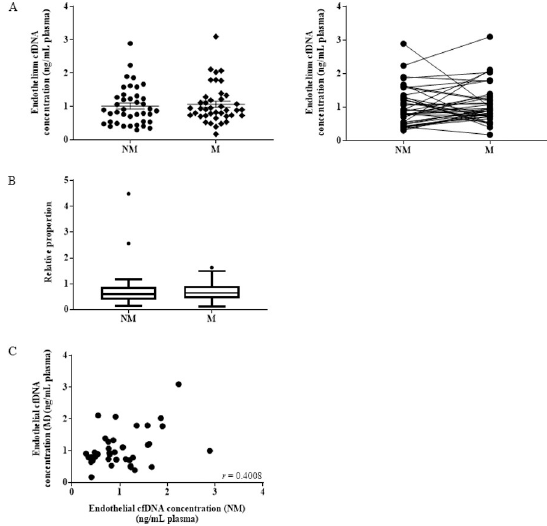
Fig 3. Endothelial cell-derived cfDNA does not increase during menstruation. (A) Measurement of endothelial cfDNA quantification by qPCR in 40 healthy women at NM and M phases, expressed in ng of cfDNA per 1 mL of plasma (p = 0.301). (B) Box plot graph showing the proportion of endothelial cfDNA compared to total cfDNA at NM and M phases (p = 0.3686). (C) Scatter plot of endothelial cfDNA at NM and M phases (r = 0.4008; p =